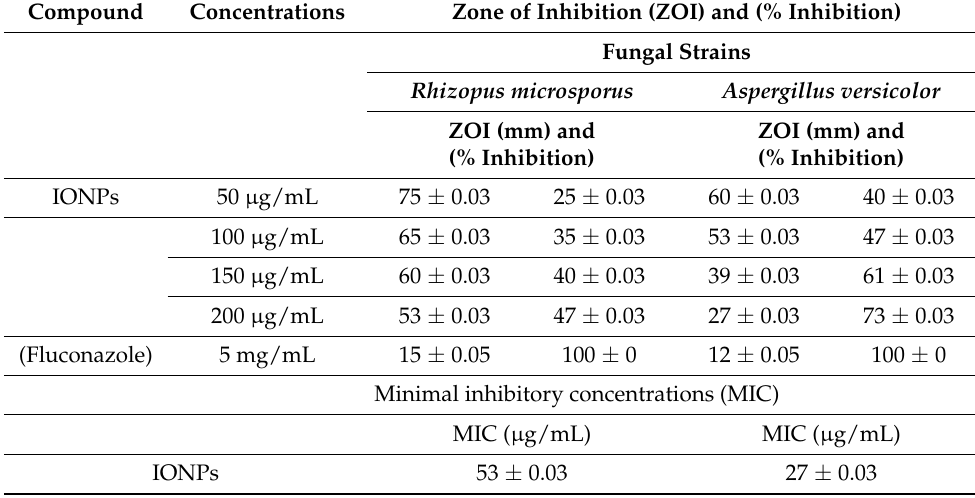
Table 3. IC 50 and FRSA values calculations for antioxidant assay.